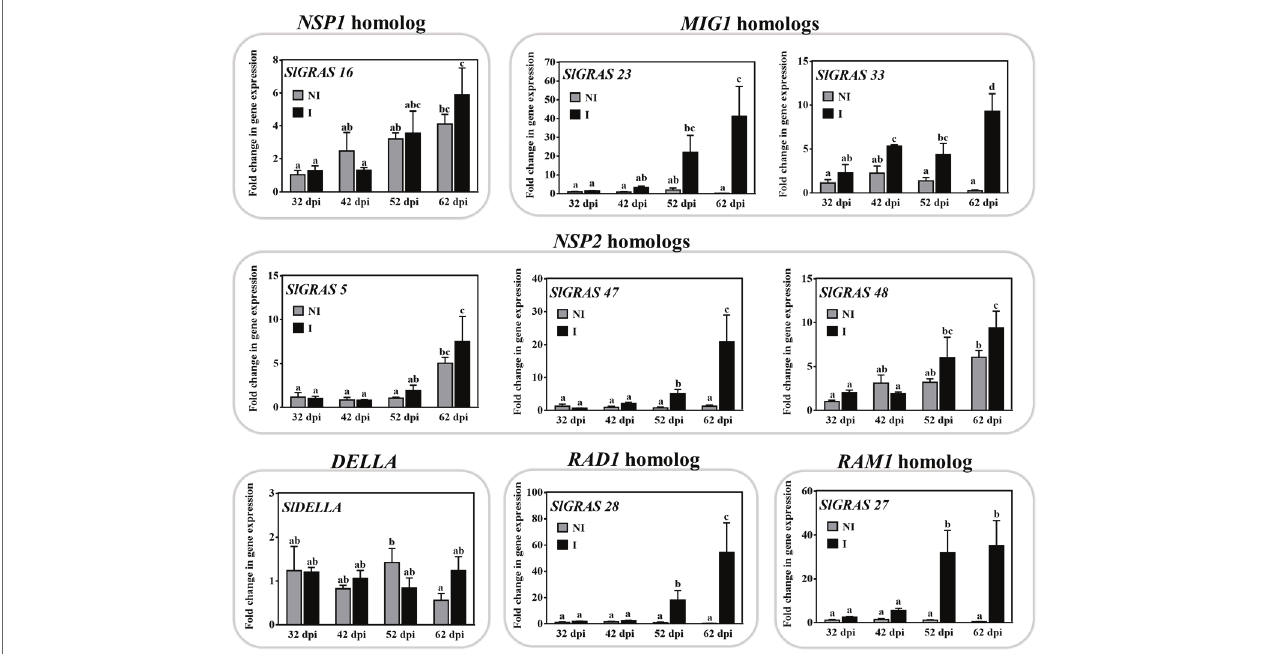
FIGURE 3 | Characterization of expression of mycorrhiza-related GRAS genes in tomato roots. The expression of several putative GRAS genes was analyzed by qPCR in tomato roots after 32, 42, 52, and 62 dpi (days post inoculation) with the AM fungus R. irregularis . The qPCR data show relative gene expression in the roots of AM-inoculated plants (I) with respect to their expression in non-inoculated (NI) plants at 32 dpi, with a gene expression of 1. Values correspond to mean ± SE ( n = 3). Bars with the same letter do not significantly differ ( p > 0.05) according to the LSD multiple comparison